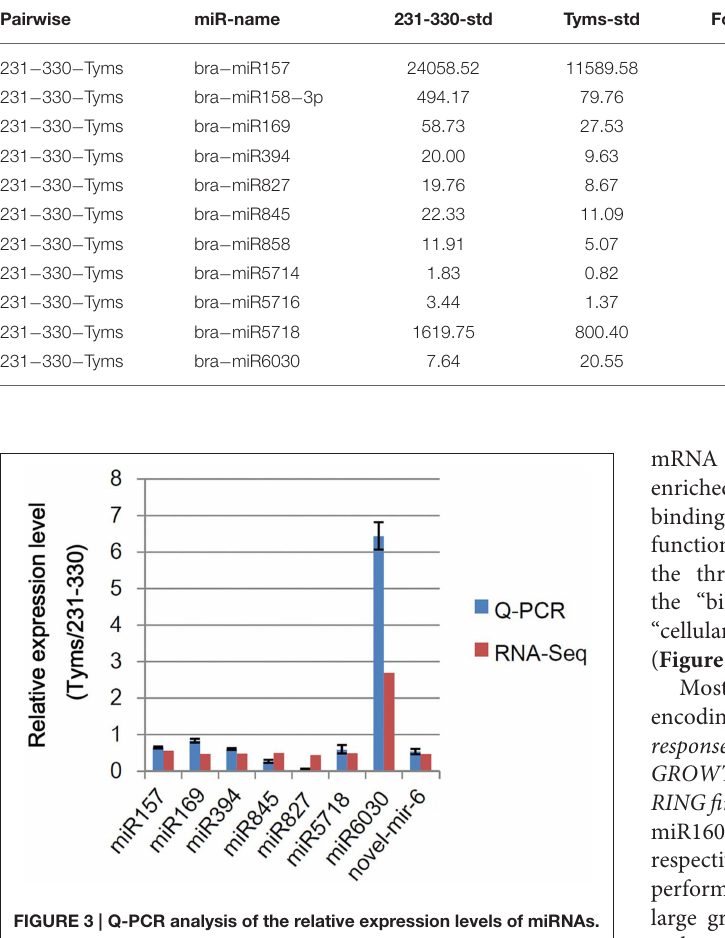
FIGURE 3 | Q-PCR analysis of the relative expression levels of miRNAs. The bars indicate the SE; four biological and three technique replicates were